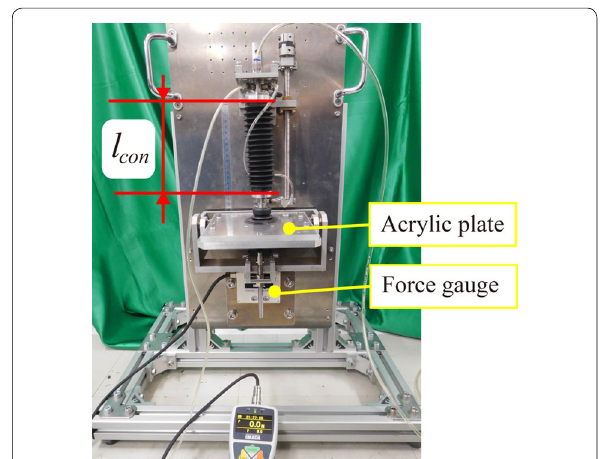
Fig. 18 Experimental parameters for contractile force evaluation